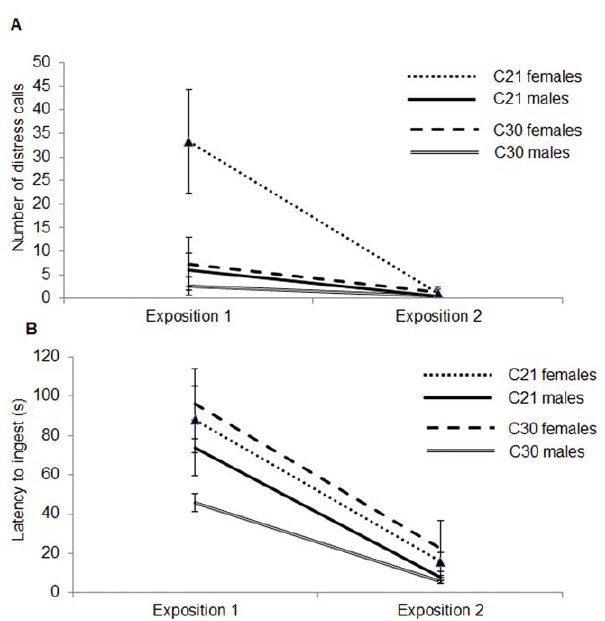
Figure 5. Mean ± SEM number of distress calls (a) and latency to ingest the novel food (b) during the first and second expositions to the novel food (C21 male chicks: N=21; C21 female chicks: N=26; C30 male chicks: N=27; C30 female chicks: N=21).